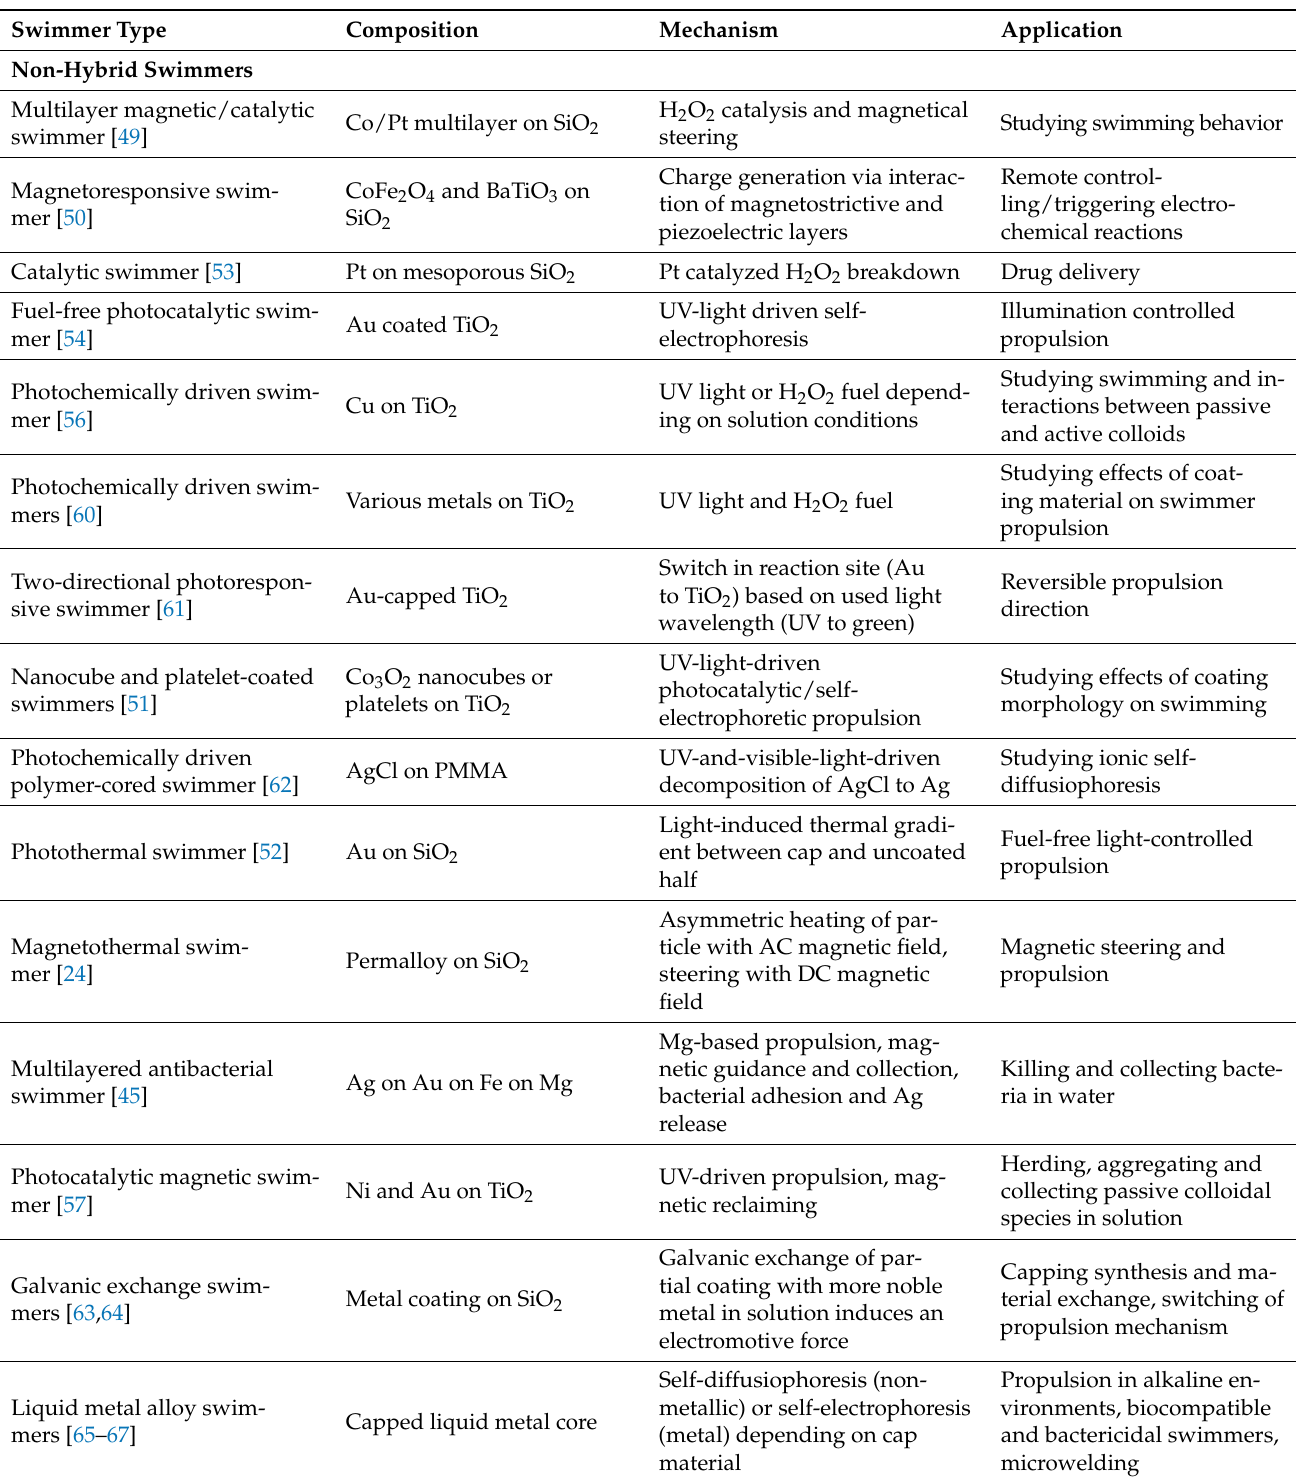
Table 1. Nanoswimmers classified by their type, composition, mechanism and foreseen